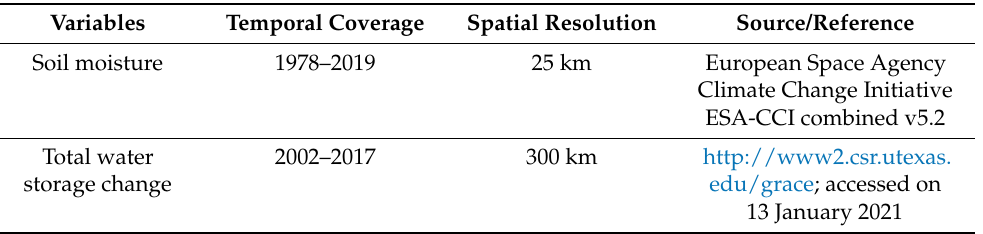
Table 1. Satellite-observation-based data products of surface soil moisture and total water storage change used for validation of the SWAT